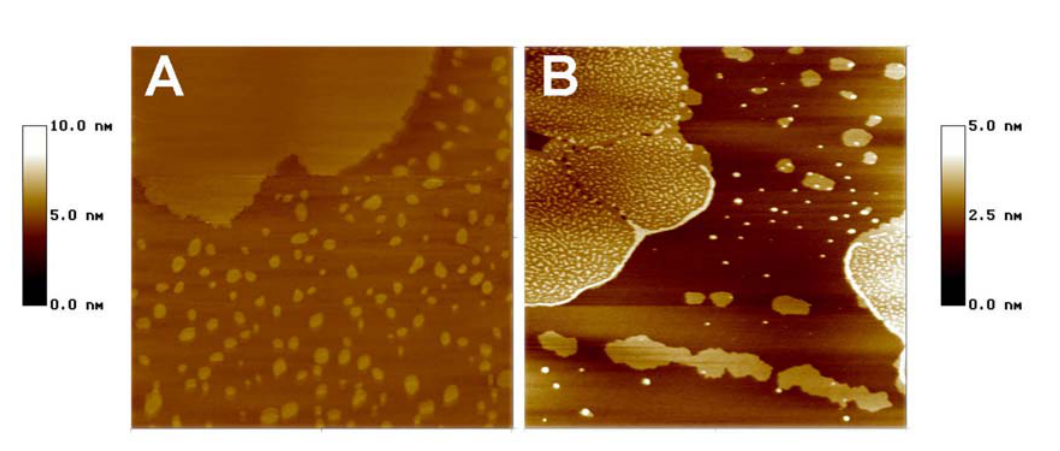
FIGURE 4 . GM 1 microdomains formation in phase-separated DOPC/DPPC films. (A) Both large and small ordered domains are observed in 1:1 DOPC/DPPC films transferred at 30 mN/m (scan size 4 µm); (B) addition of 4 mol% GM1 induces the formation in the ordered phase of small microdomains which can fuse to form fencelike structures at the large domains/matrix boundary (scan size 2 × 2